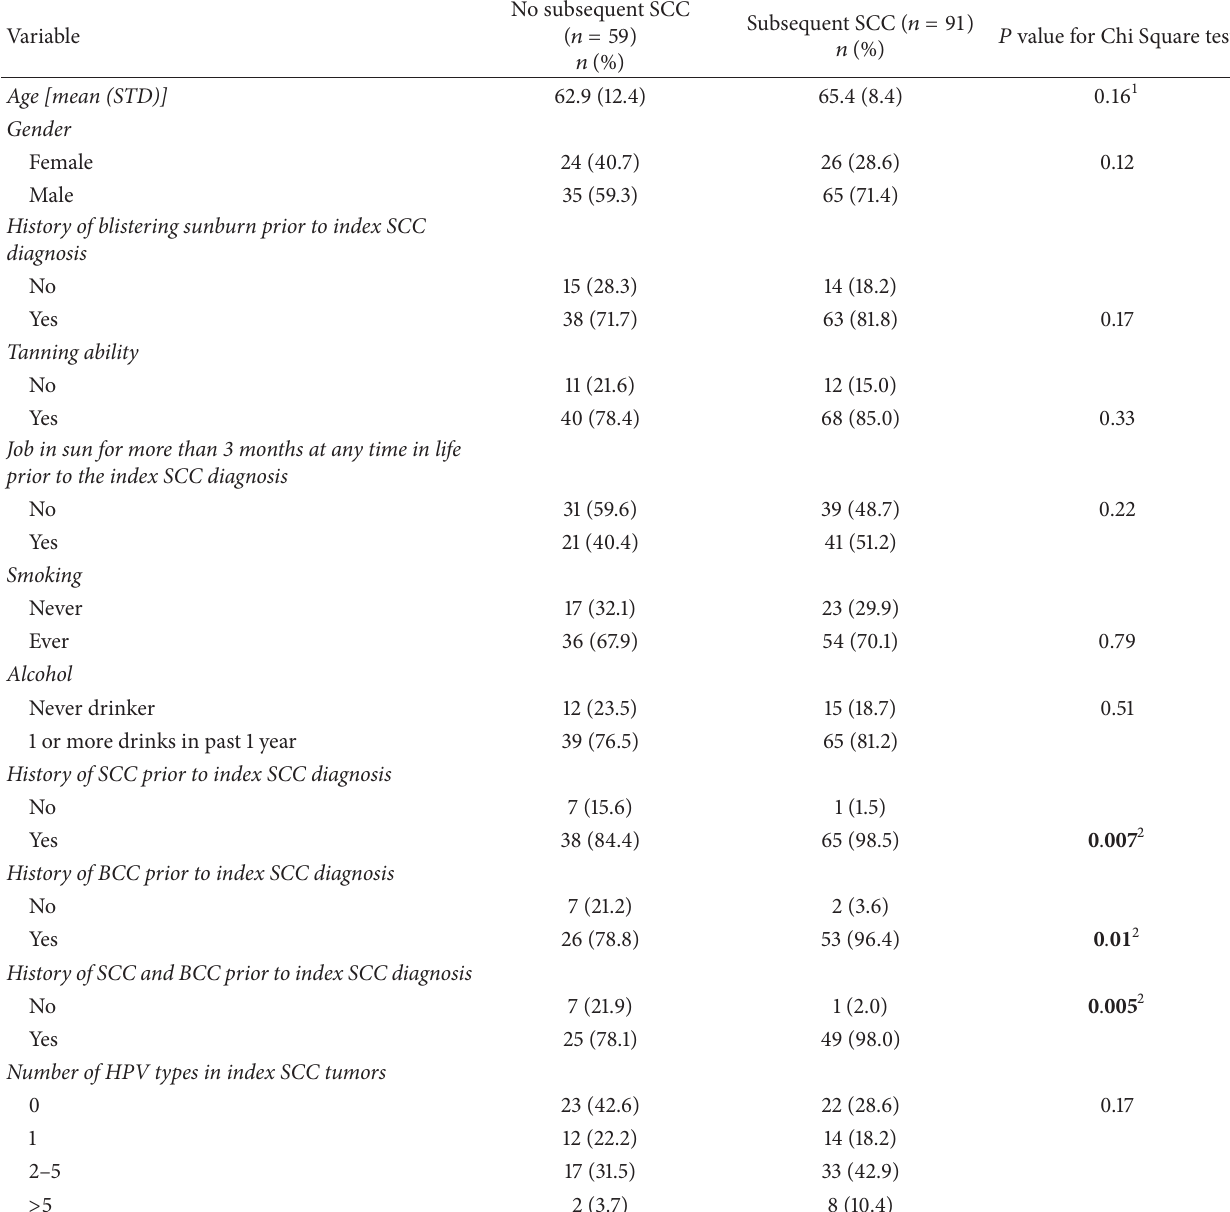
Table 2: Associations between baseline skin cancer risk factors and subsequent cutaneous squamous cell carcinoma (SCC).